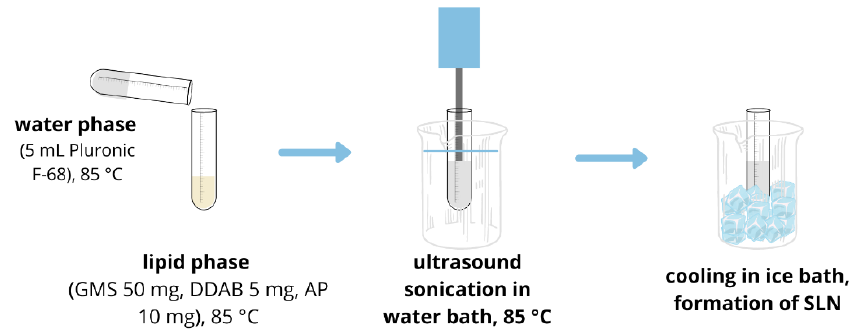
Figure 3. Synthesis of solid lipid nanoparticles.